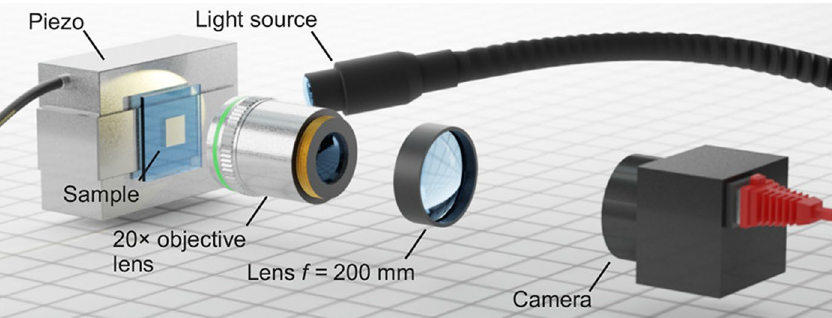
Figure 1. Scheme of the simple optical setup used to determine two-dimensional displacement vectors of a macroscopic sample with atomic-scale localization errors. The surface of a sample is illuminated by unpolarized visible white light from a filtered incandescent source impinging onto the sample under an angle. An objective 8.25mm ) together with a tube lens (with focal length f 200 mm ) images the lens (with focal length f = = 0.4 sample surface onto a digital black/white camera. The objective lens has a numerical aperture of NA = and a free working distance of 11.2mm . The images acquired by the camera are processed using image cross-correlation analysis. We can displace the sample in the plane normal to the optical axis by a precision piezoelectric stage. The setup is located on a vibration-isolated optical table and enclosed in a box to reduce vibrations and drifts between the sample and the camera position.